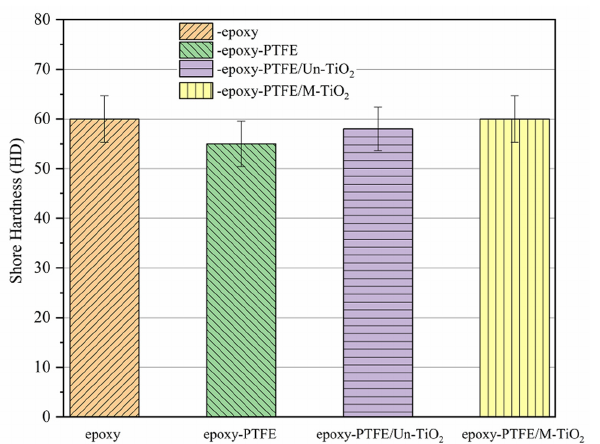
Figure 4. Hardness of different coatings.